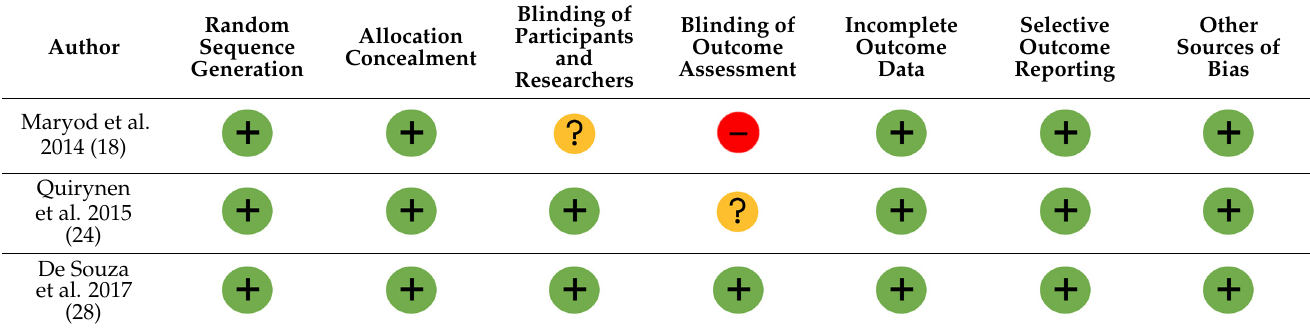
Table 3. Risk of bias of included non-randomized clinical trials. 0 (not reported), 1 (reported but inadequate) or 2 (reported Table 2. Risk of Bias of included randomized clinical trials. +: Low; ?: Unclear; − : High. and adequate), NE (not evaluable, no group control). Table 2. Risk of Bias of included randomized clinical trials. +: Low; ?: Unclear; − : High. Table 2. Risk of Bias of included randomized clinical trials. +: Low; ?: Unclear; − : High. Table 2. Risk of Bias of included randomized clinical trials. +: Low; ?: Unclear; − : High. Table 2. Risk of Bias of included randomized clinical trials. +: Low; ?: Unclear; − : High. Table 2. Risk of Bias of included randomized clinical trials. +: Low; ?: Unclear; − : High. Table 2. Risk of Bias of included randomized clinical trials. +: Low; ?: Unclear; − : High. Table 2. Risk of Bias of included randomized clinical trials. +: Low; ?: Unclear; − : High. Table 2. Risk of Bias of included randomized clinical trials. +: Low; ?: Unclear; − : High. Table 2. Risk of Bias of included randomized clinical trials. +: Low; ?: Unclear; − : High. Table 2. Risk of Bias of included randomized clinical trials. +: Low; ?: Unclear; − : High. Table 2. Risk of Bias of included randomized clinical trials. +: Low; ?: Unclear; − : High. Table 2. Risk of Bias of included randomized clinical trials. +: Low; ?: Unclear; − : High. Table 2. Risk of Bias of included randomized clinical trials. +: Low; ?: Unclear; − : High. Table 2. Risk of Bias of included randomized clinical trials. +: Low; ?: Unclear; − : High.